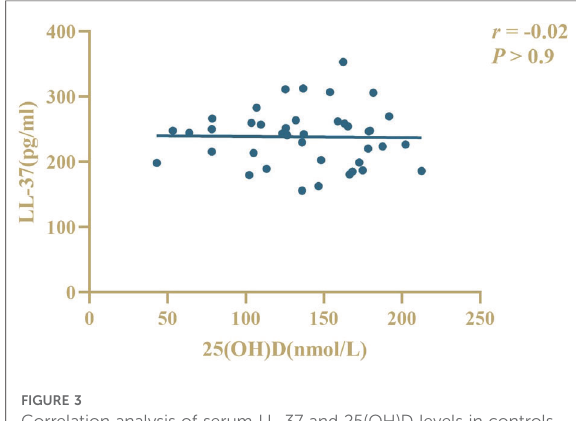
FIGURE 3 Correlation analysis of serum LL-37 and 25(OH)D levels in controls.